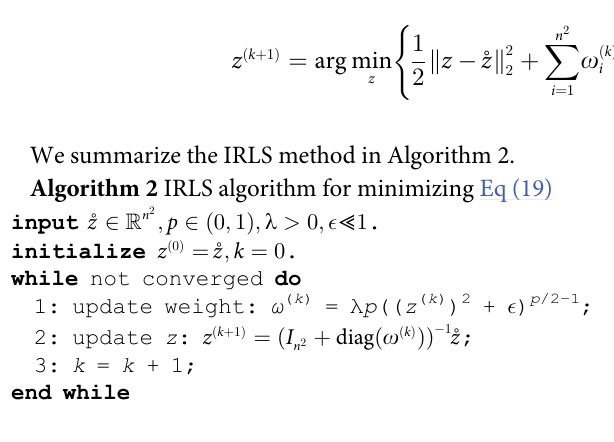
Algorithm 2 IRLS algorithm for minimizing Eq